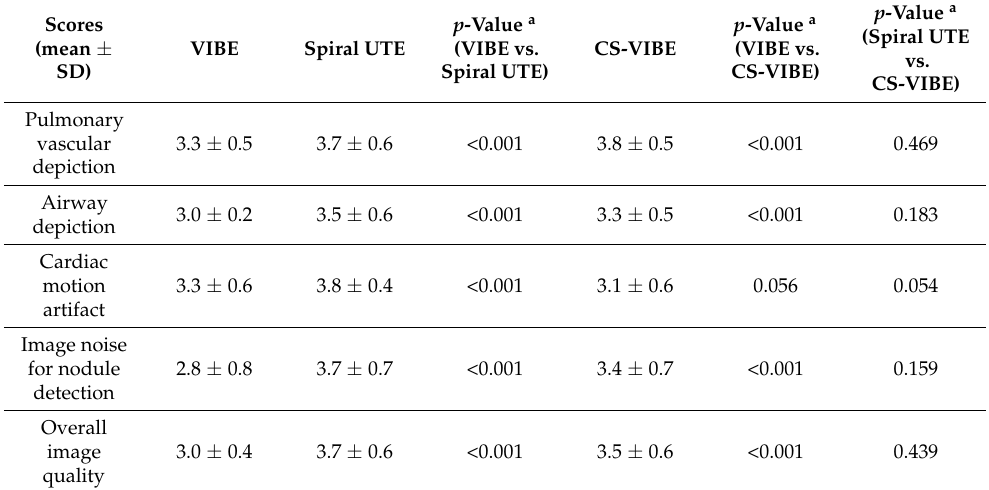
Table 3. Qualitative assessment of normal structures and overall diagnostic acceptability of lung MR